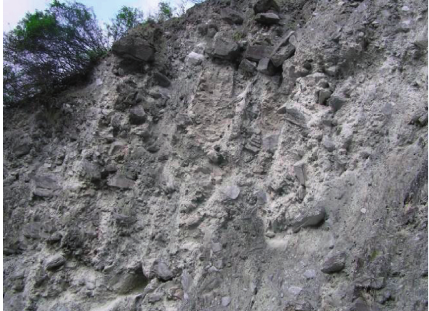
Figure 5: Gravel and rock retaining the sequence structure of primary rock in partition I at 960 ∼ 1,200m.